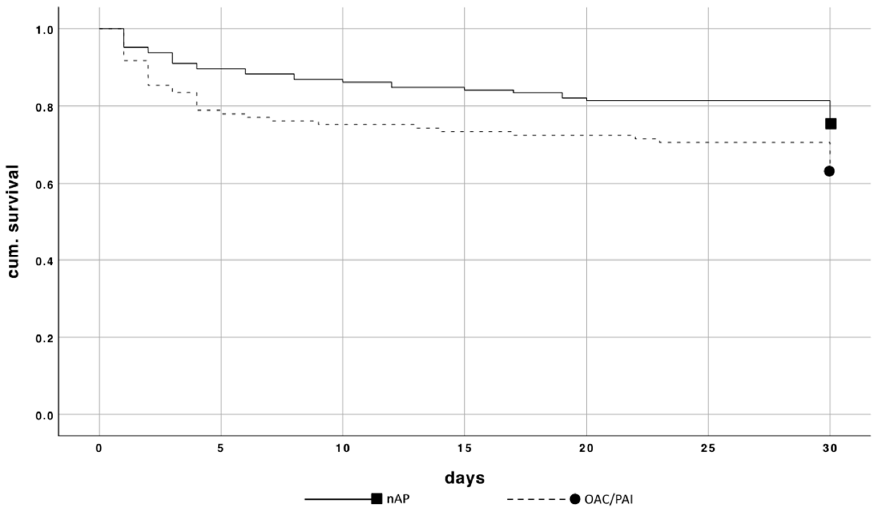
Figure 4. Kaplan–Meier curve of 30-day mortality comparing patients with and without OAC/PAI.